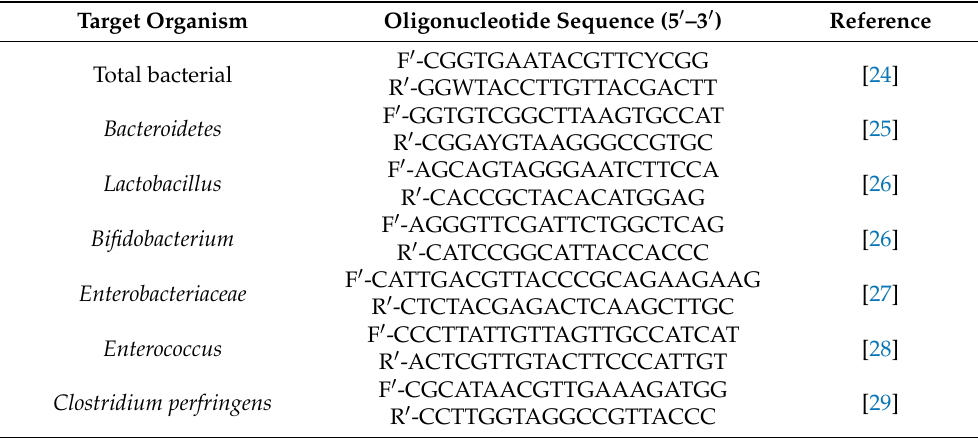
Table 2. Primers used for bacteriological